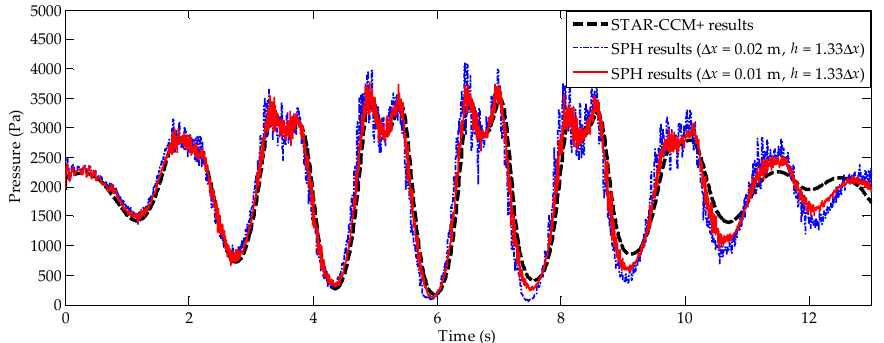
= Δ for the pressure on the solid